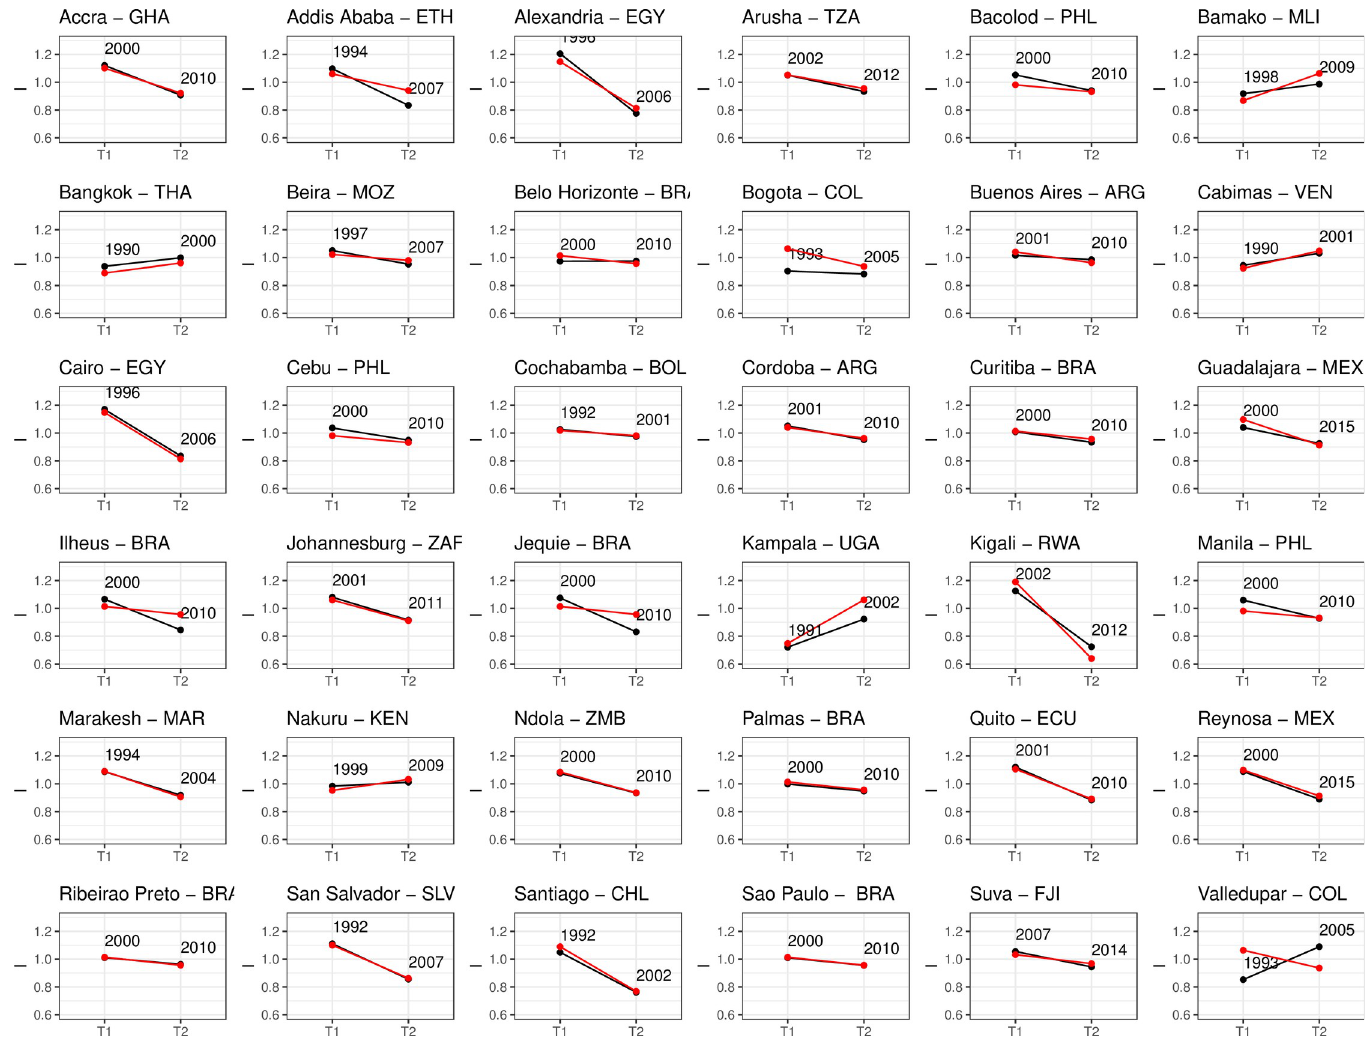
Fig 4. Evolution of Asset Inequality Index for selected cities (in black) and countries (in red).